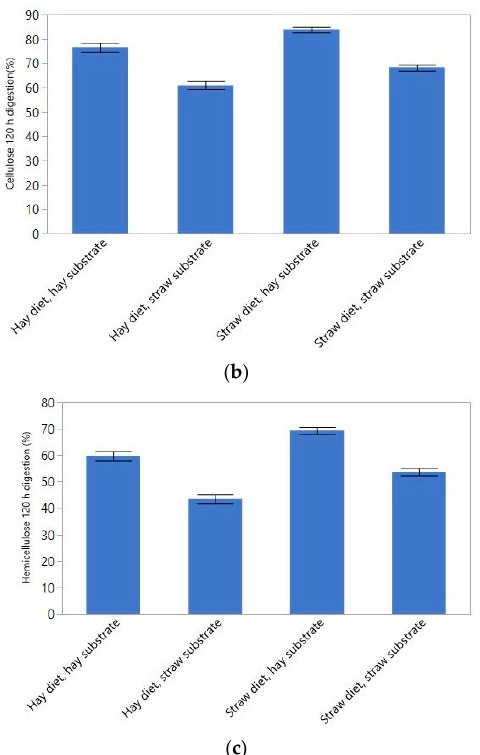
Figure 1. Digestion (%) of NDF ( a ), cellulose ( b ), and hemicellulose ( c ), at 120 h in nylon bags with different substrates and animals on different diets.